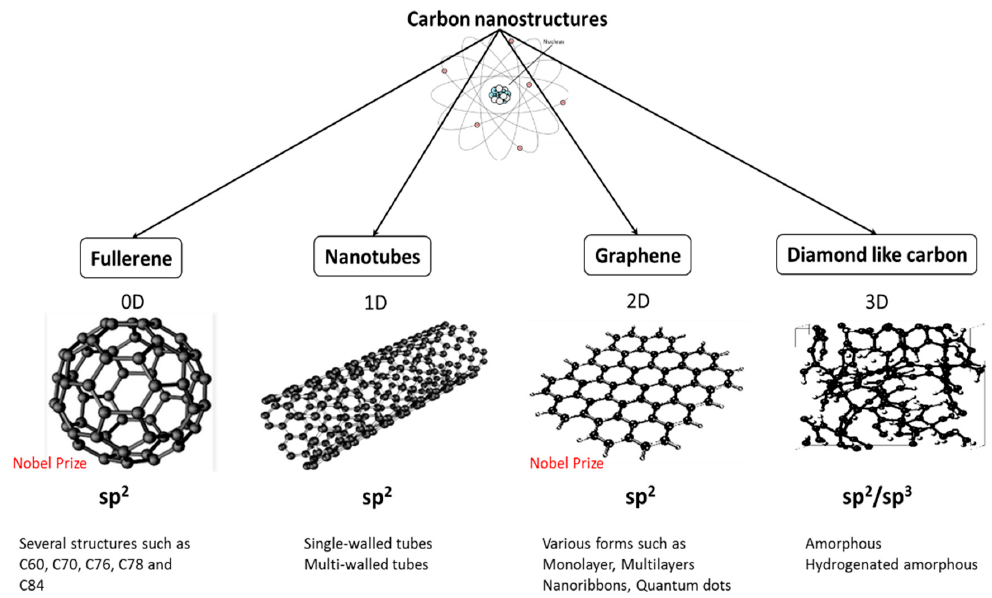
Figure 1. Several forms of carbon nanostructures.